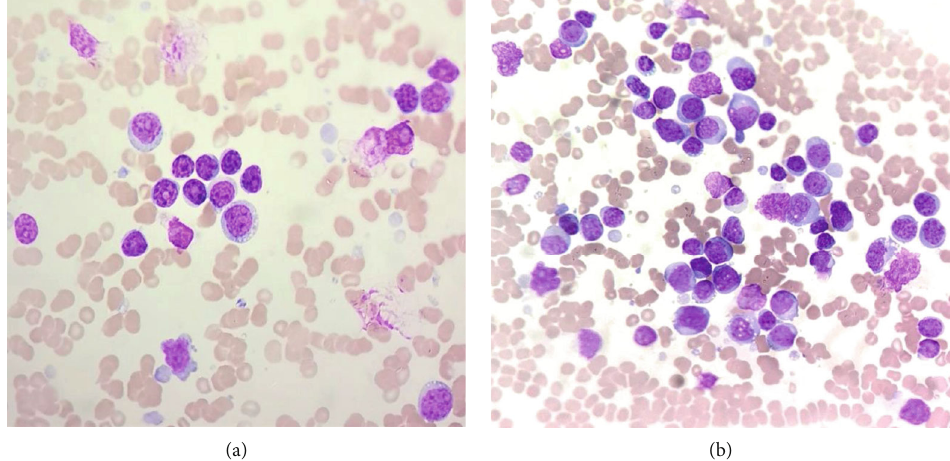
Figure 1: (a) Blood smear showed small lymphocytes, smudged and large lymphoid cells. (b) Large immature lymphoid cells with prominent nucleoli and basophilic vacuolated cytoplasm in the bone marrow